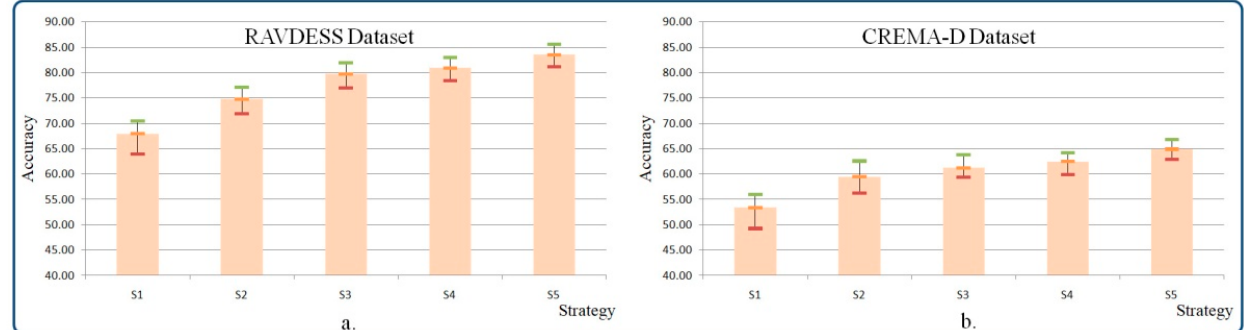
Figure 8. The statistical experimental results of the considered databases: ( a ) RAVDESS, ( b ) CREMA ‐ D. Figure 9 presents the confusion matrices obtained on the two considered